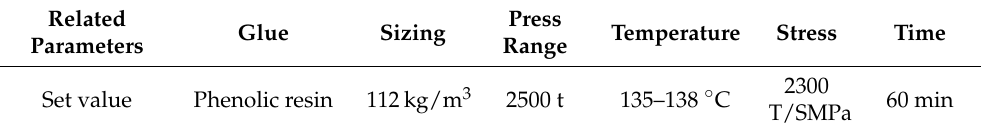
Table 1. Hot-pressing process parameters.